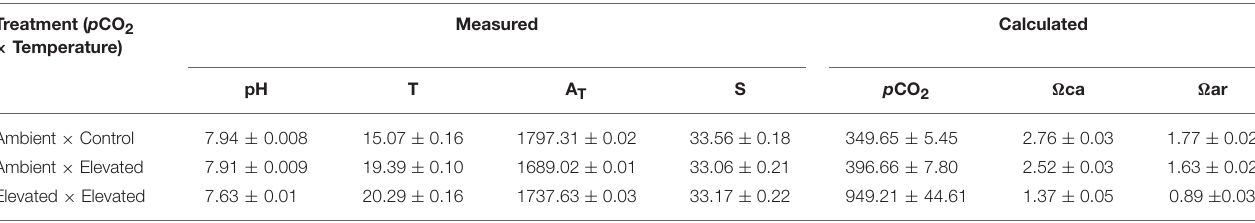
TABLE 1 | Physical and chemical characteristics of seawater in the three experimental treatments for Crassostrea gigas [presented as mean values over the duration of the experiment ± standard deviation (s.d.)]. Treatment ( p CO 2 Measured Calculated × Temperature) pH